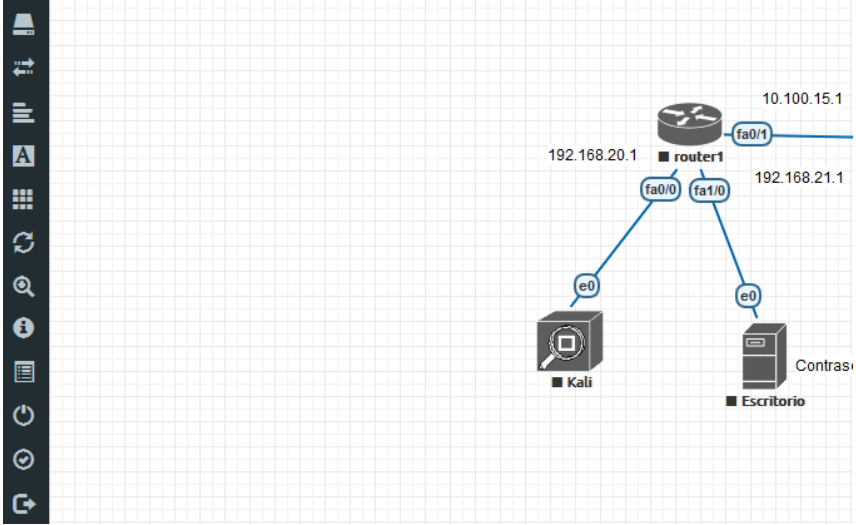
Figure 1. Example of Laboratory in the